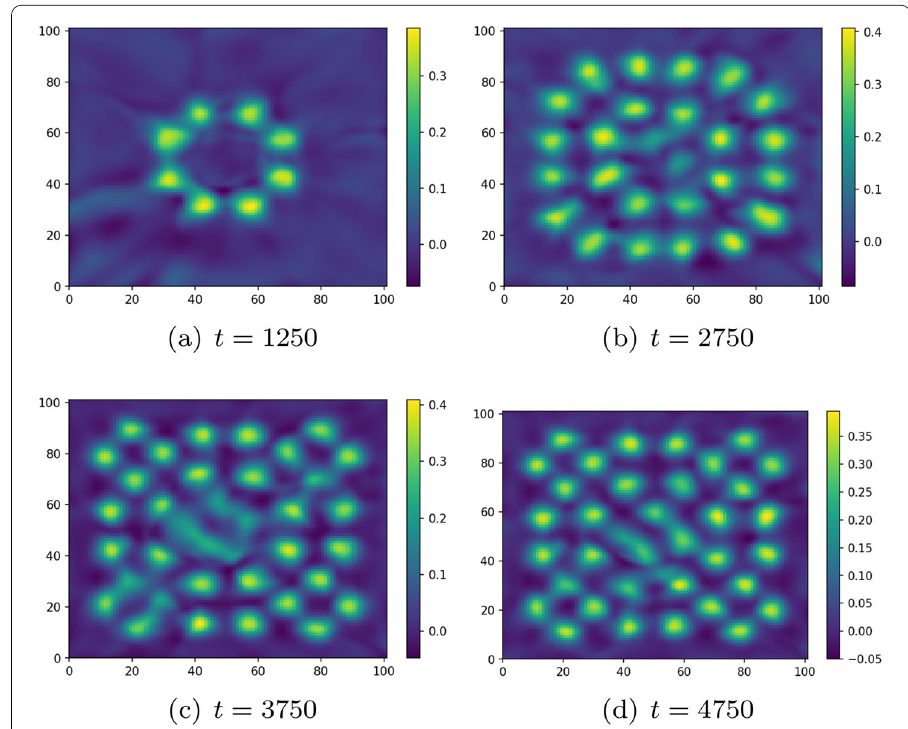
Fig. 7 Example of Mitosispatterns . The parameters used in the (3) are F = 0 . 028 and K = 0 . 062. The times shown are: t = 1250 , 2750 , 3750 ,